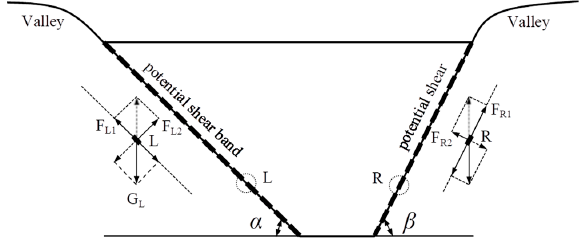
Figure 2. Mechanical diagram of asphalt concrete core in potential shear band .